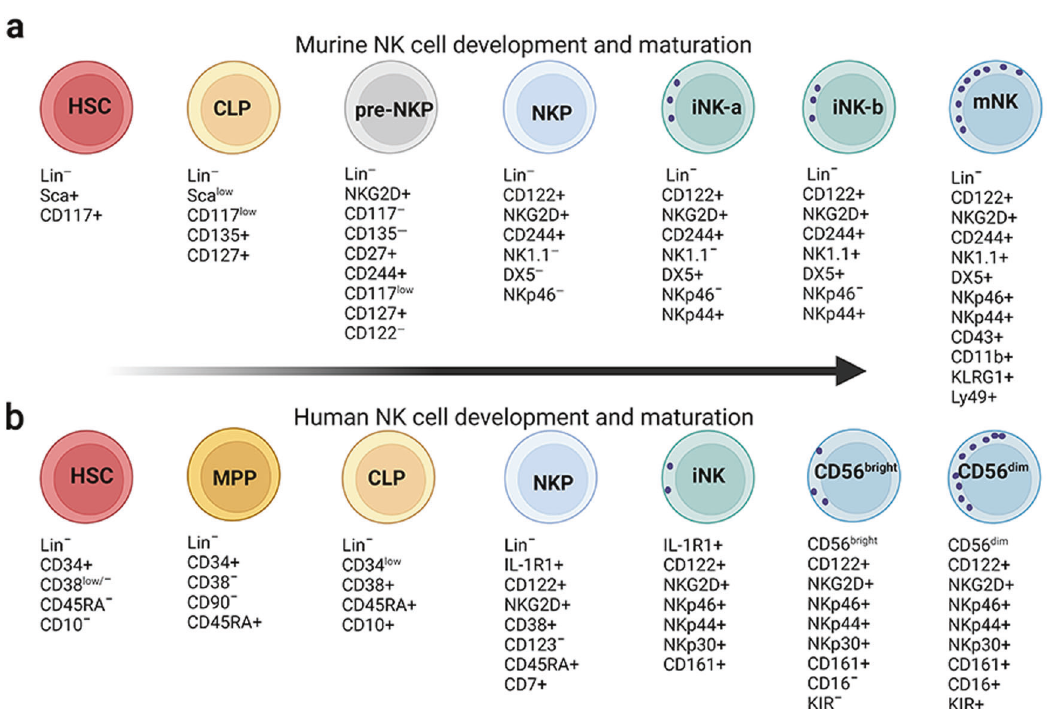
Fig. 2 Schematic representation of the cellular intermediates in both murine and human NK cell development. Surface antigens help distinguish the intermediate populations in NK development. a Linear path (left to right) in the development of murine NK cells from HSC to mature CD11b + CD27 − DX5 + NK cells. b Linear path (left to right) in the development of human NK cells from HSC to mature CD56 dim NK cells. + (expression), − (no expression), hi (high expression), low (low expression). Created with